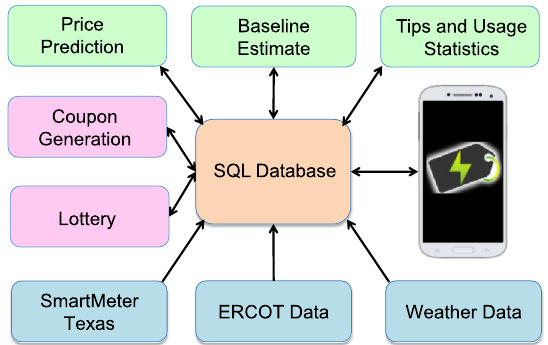
Fig. 1 System architecture